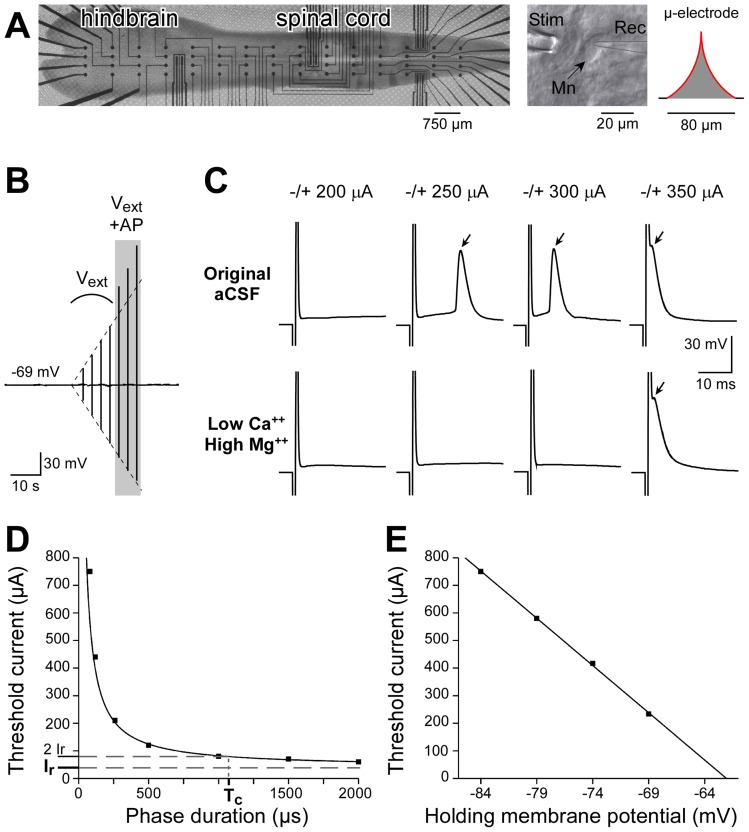
Experimental protocol of extracellular stimulations.
A: Dorsally-opened hindbrain-spinal cords of (n = 9) E14.5 mouse embryos were positioned on MEAs, with the side of the central canal facing the 4×15 microelectrodes of the array (left). In each preparation, one motoneuron was patch-clamped in whole cell configuration, and stimulated using both a glass pipette positioned close to its cell body (middle) and the microelectrodes of the MEA. The theoretical shape of the 3D microelectrodes (height: 80 µm, base diameter: 80 µm) is shown on the right (the conductive part is in red, the insulated part is in black). B: Current-clamp recording during a series of stimuli with increasing intensities. In order to perform all trials in the same conditions, a slow holding current (time constant: 5 s) was injected to maintain Vm at a corrected value of about −69 mV. The dashed line highlights the fact that the amplitude of the signal increases linearly with the pulse intensity (here steps of 50 µA) until an action potential is elicited which superimposes on top of the extracellular potential (3 shaded events). C: Threshold currents (TCs) were determined by increasing regularly the intensity of the cathodic-first biphasic current-controlled pulse. Under standard aCSF, indirect activations of the neuron were observed (top row), while only direct activations were achieved using a low Ca2+/high Mg2+ aCSF solution (bottom row). D: The motoneuron chronaxie (Tc) was calculated by determining TCs for different phase durations and fitting the hyperbolic Weiss's law [32]. On average, we found Tc = 913±132 µA (n = 3). Based on this value, we chose a phase duration of 1 ms for all experiments. E: Activation thresholds decreased linearly with holding membrane potential values.